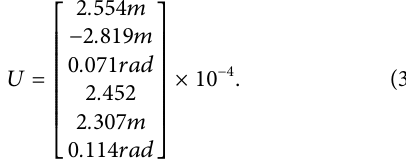
The fi rst three lines of Eq. 34 represent the displacement and rotation angle of node 2, and the last three lines represent the displacement and rotation angle of node 3.